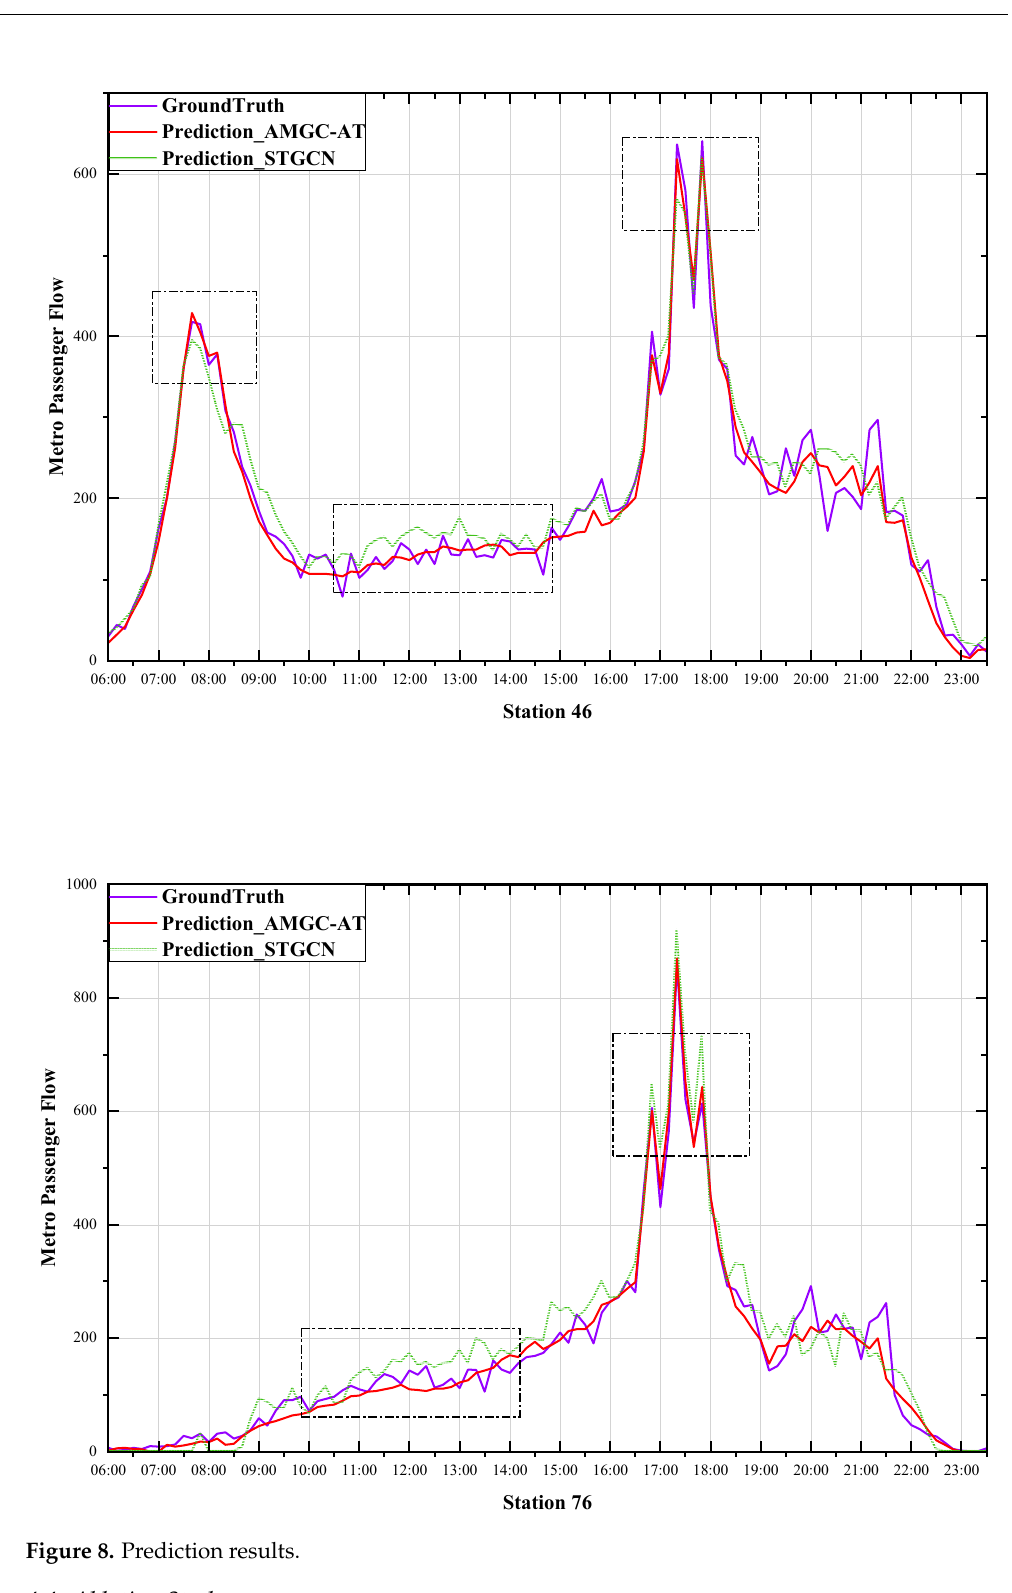
Figure 8. Prediction results.